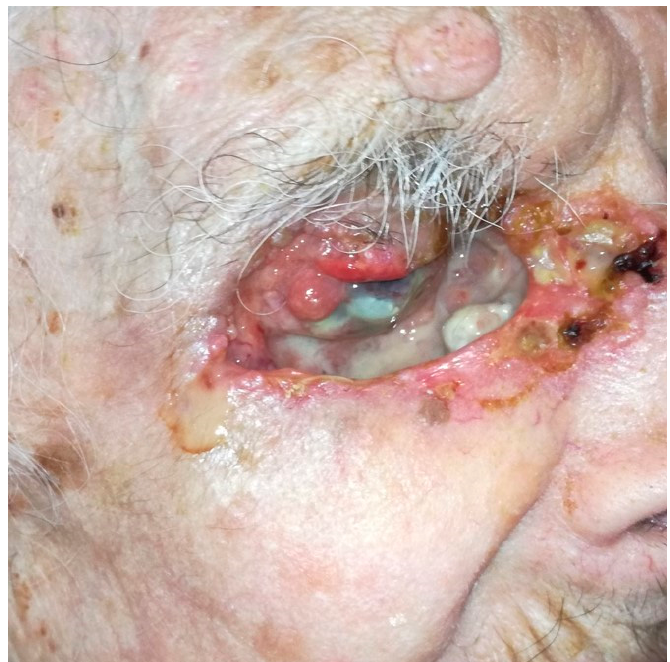
Figure 3. ‘ Pseudo-orbital exenteration’ of an eyelid BCC with orbital invasion.